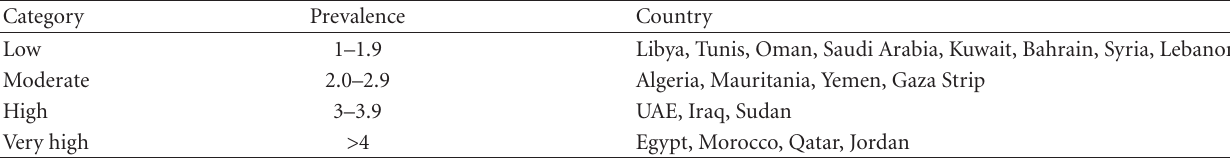
Table 2: Categorization of Arab countries according to the prevalence hepatitis C